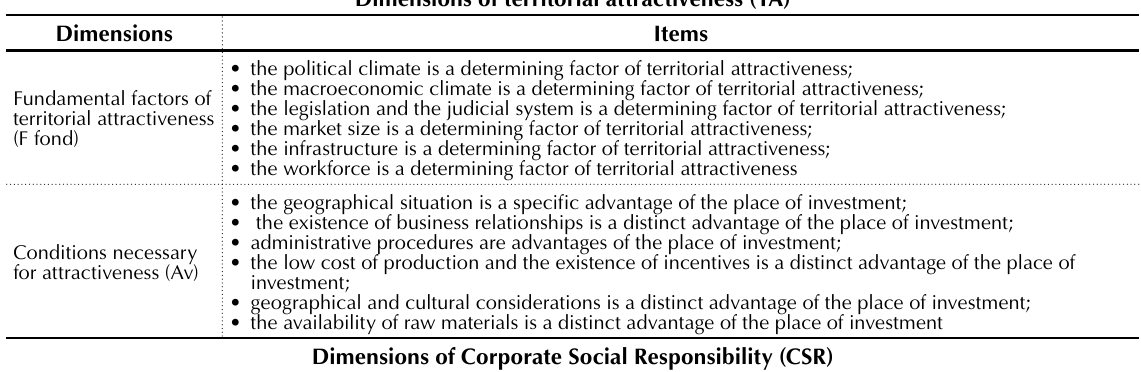
Table A1. Conceptualization of